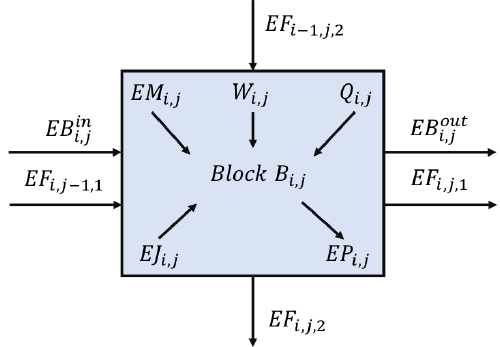
Figure 5. Illustration of energy balance on block B i , j